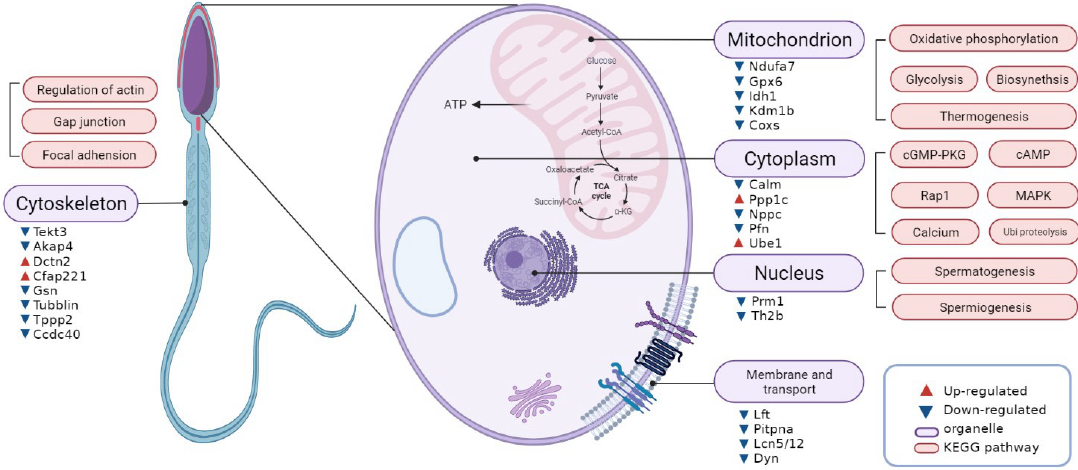
Figure 7. The subcellular location and regulatory pathways of